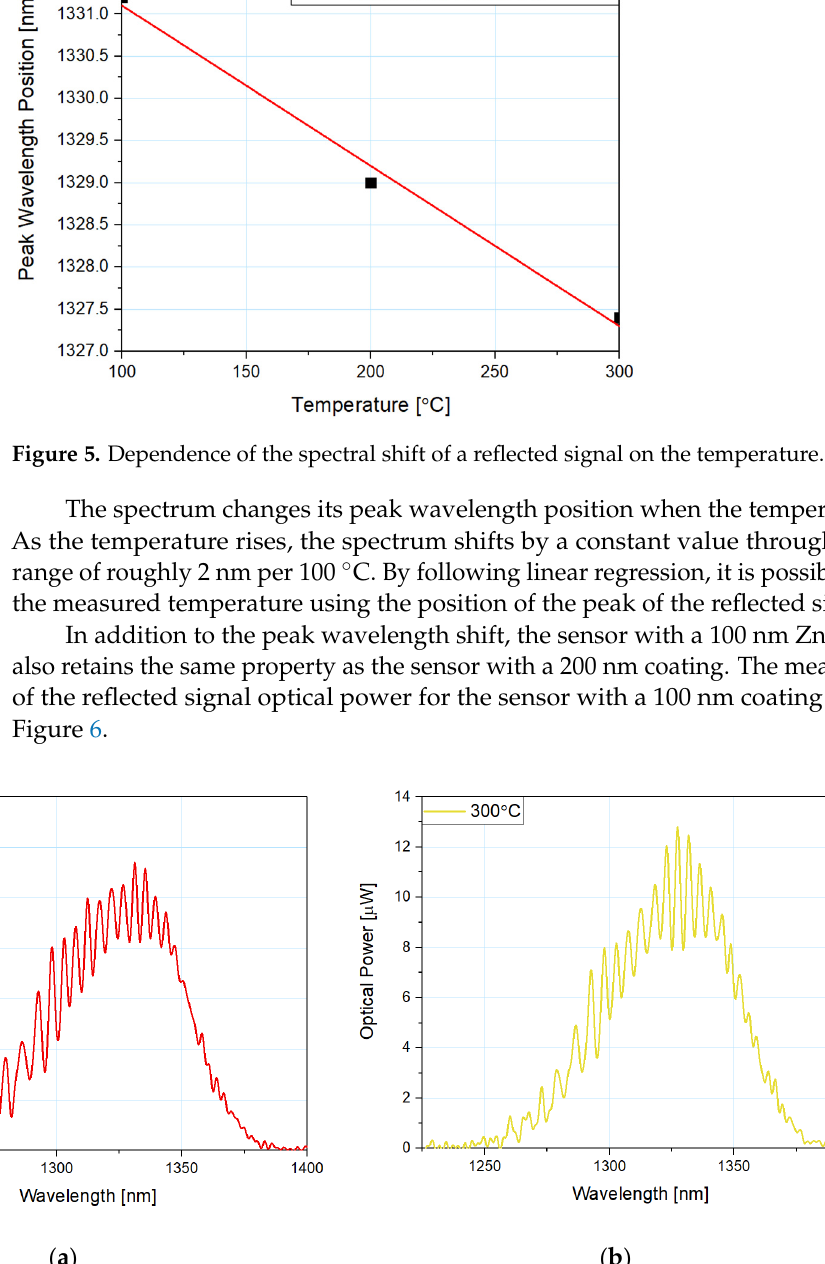
Figure 4. Normalized measured response of the reflected signal for the microsphere-based sensor with 100 nm ZnO ALD coating at ( a ) 100 °C and ( b ) 300 °C.